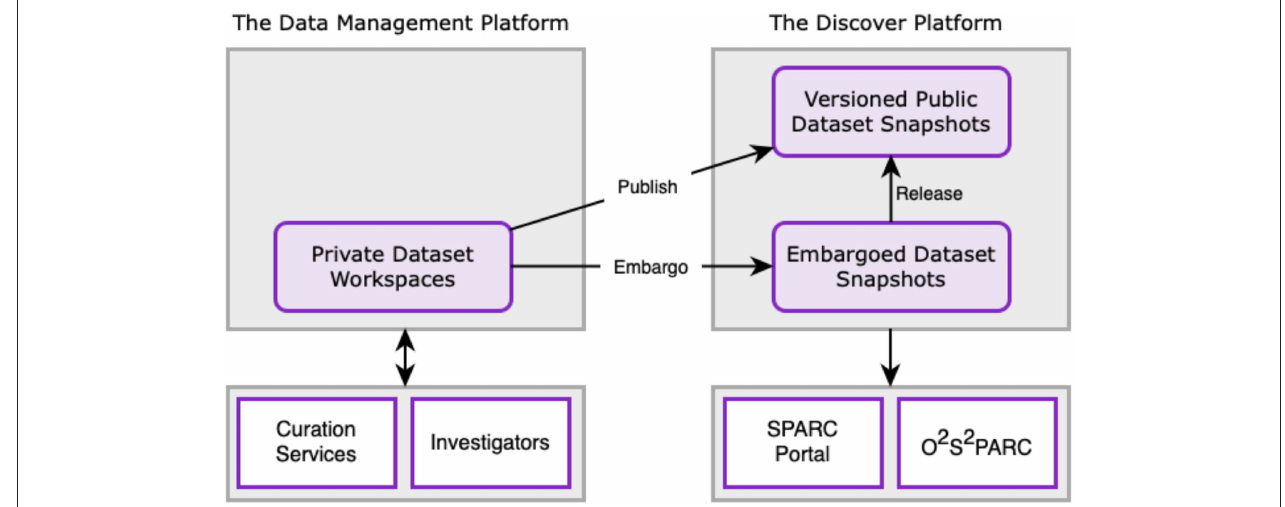
FIGURE 2 | Schematic overview of the relationship between the DMP, Discover, SPARC portal, and o 2 S 2 PARC applications. Data are uploaded to the DMP and curated through the SPARC curation workflow. Once a dataset is curated, a snapshot of the dataset is persisted in the Discover platform and a DOI is assigned. Initially, the data is released as an embargoed dataset, with a final release date on which the entire dataset is made publicly available. Users have the ability to request early access to embargoed data through the platform after signing a SPARC Data Use